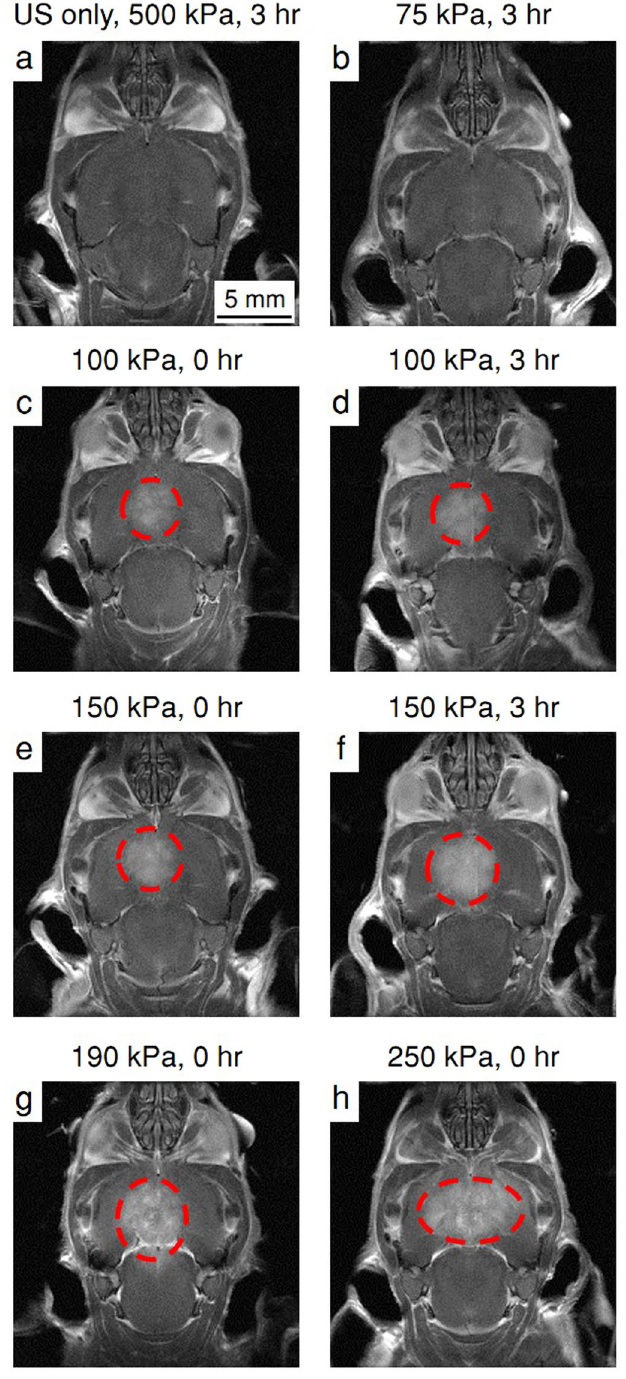
Figure 7. Coronal T1-weighted MR images. The contrast enhancement area is indicated by the red dashed circles. ( a ) US (ultrasound)-only with 500 kPa peak negative pressure (PNP), 3 hours post treatment. ( b ) ultrasound + MBs with 75 kPa PNP, 3 hours post treatment. ( c , d ) Ultrasound + MBs with 100 kPa PNP, at 0 and 3 hours post treatment respectively. ( e , f ) Ultrasound + MBs with 150 kPa PNP, at 0 and 3 hours post treatment respectively. ( g ) Ultrasound + MBs with 190 kPa PNP, at 0 hours post treatment. ( h ) Ultrasound + MBs with 250 kPa PNP, at 0 hours post